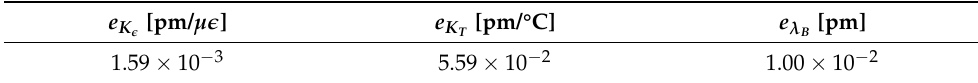
Table 4. Estimated error for each error factor.